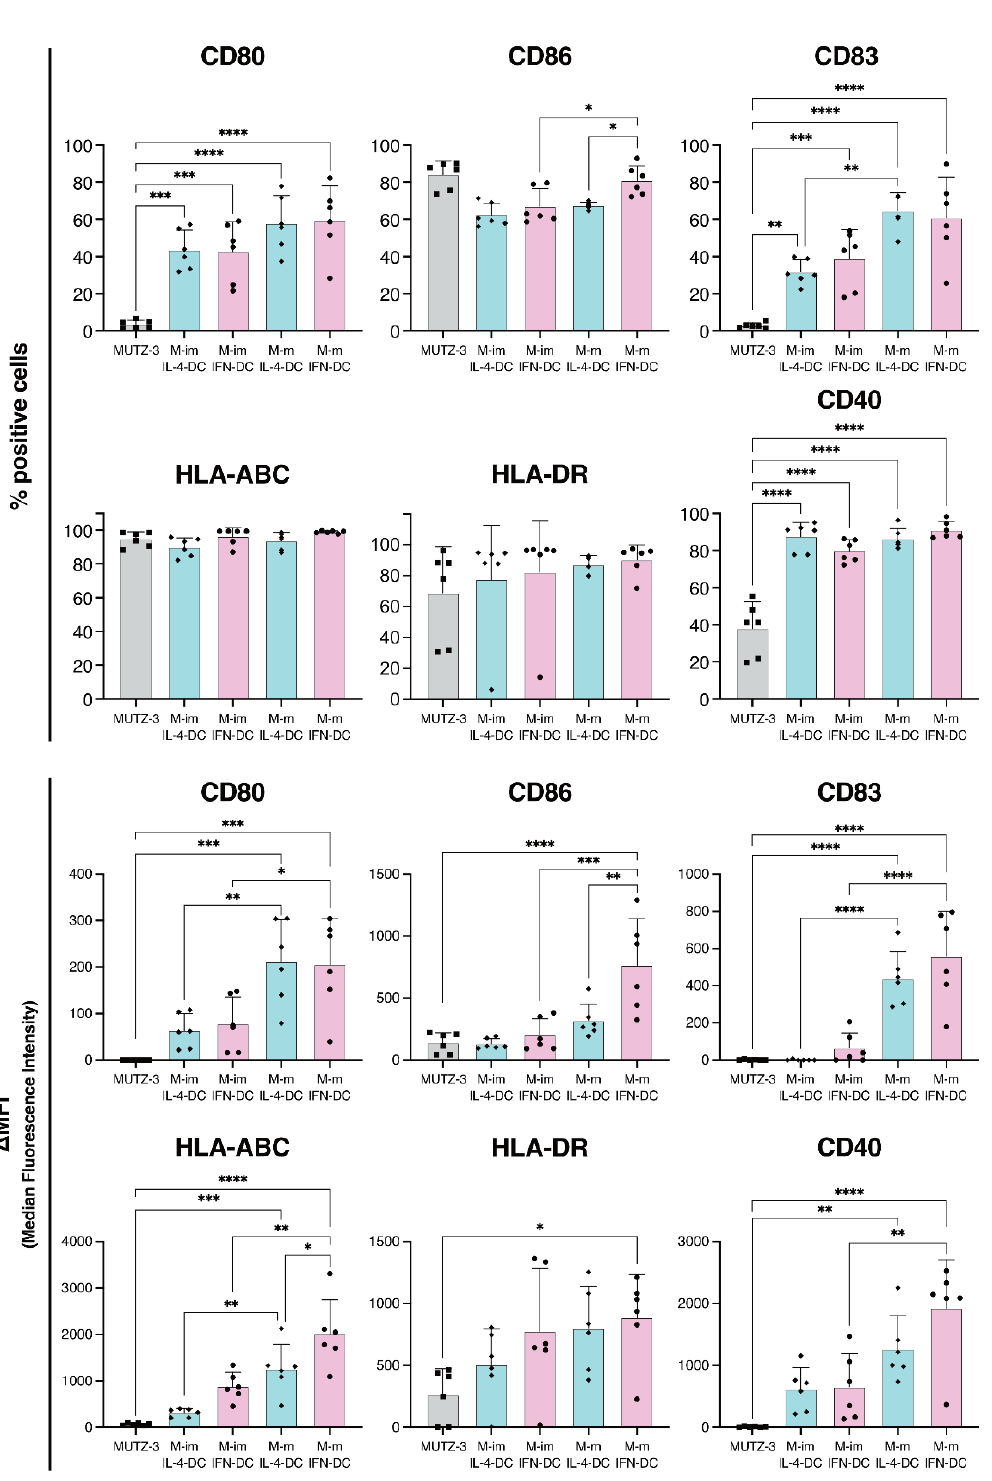
Figure 3. Comparison of immature and mature MUTZ3-derived IL-4-DCs and IFN-DCs phenotypes (M-imIL-4-DC, M-imIFN-DC, M-mIL-4-DC, and M-mIFN-DC). The results are shown as the percentage of positive cells and ΔMFI. The Δ median fluorescence intensity (ΔMFI) was calculated by subtracting the isotype control MFI values from the observed values. * p < 0.05, ** p < 0.01, *** p < 0.001, and **** p < 0.0001 indicate statistically significant differences ( n = 6). The bars indicate the mean ± S.D. of independent experiments. The rhombus in the Scatter plot is MUTZ-3 derived IL-4-DCs. Circle is MUTZ-3 derived IFN-DCs. Square is MUTZ-3 cells.